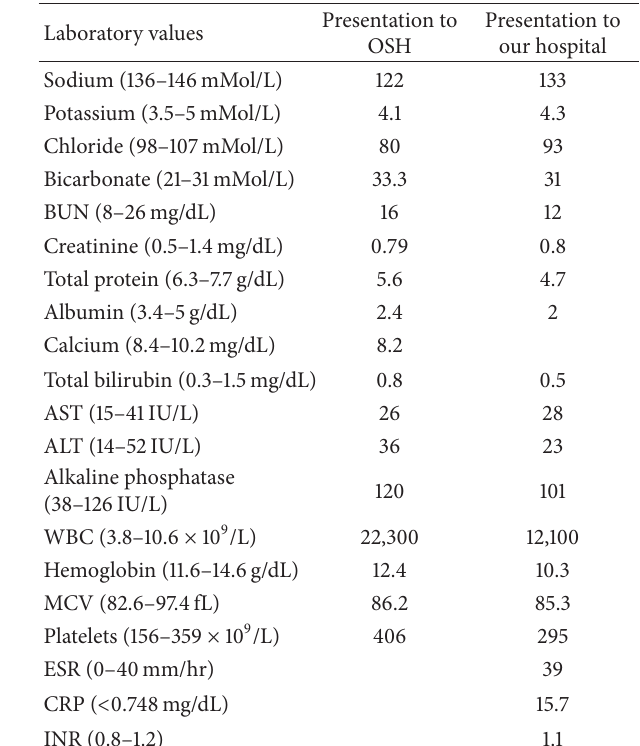
Table 1: Laboratory values at presentation to the outside hospital and at presentation to our